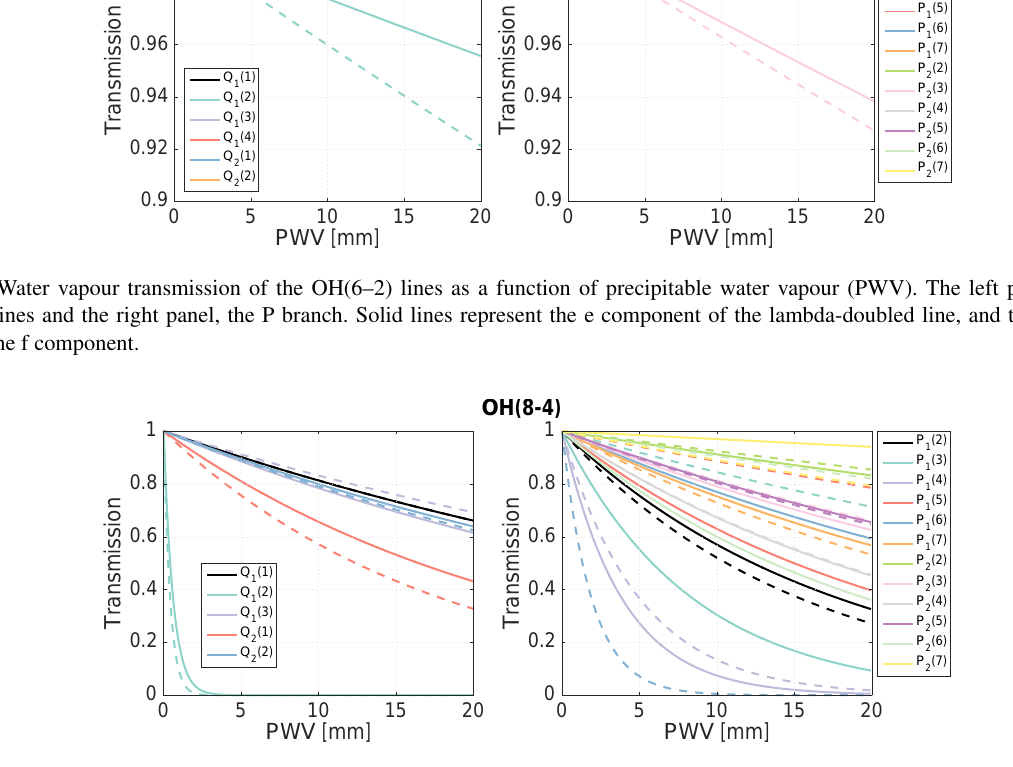
Figure 8. Water vapour transmission of the OH(8–4) lines as a function of precipitable water vapour (PWV). The left panel shows the Q-branch lines and the right panel, the P branch. Solid lines represent the e component of the lambda-doubled line, and the dashed lines represent the f